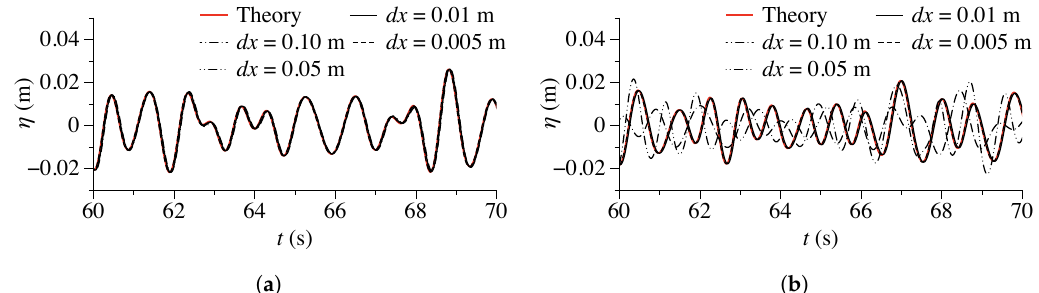
Figure 2. Comparison of the theoretical input and reconstructed irregular wave signal for case A ( a ) W1 ( x = 0 m); ( b ) W2 ( x = 11 m).